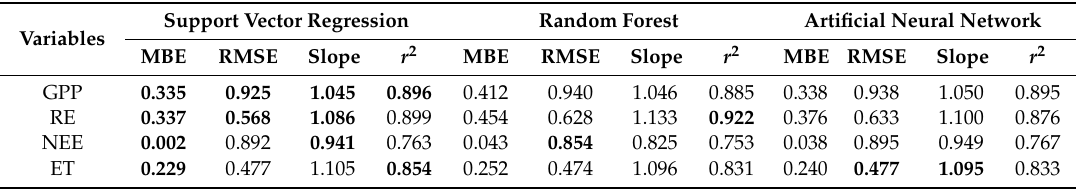
Table 5. Statistical parameters for error assessment of Experiment 3-6 using SVR, random forest (RF), and artificial neural network (ANN). MBE and RMSE indicate mean bias error and root-mean-square error, respectively (Units: g C m − 2 day − 1 for GPP, RE and NEE, mm day − 1 for ET). Slope and r 2 obtained from linear regression analysis. Numbers in bold indicate the best estimations based on each of the statistical parameters for error assessment.